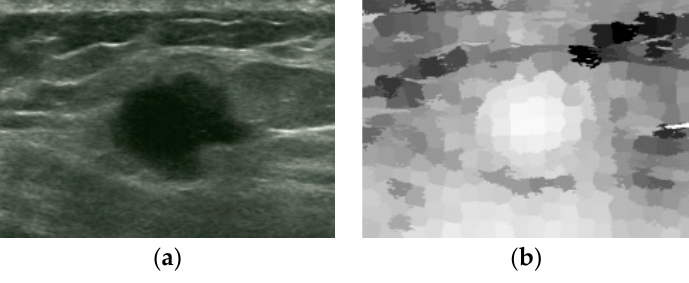
Figure 7. Original image and superpixel saliency map: ( a ) Original image. ( b ) Superpixel saliency map.